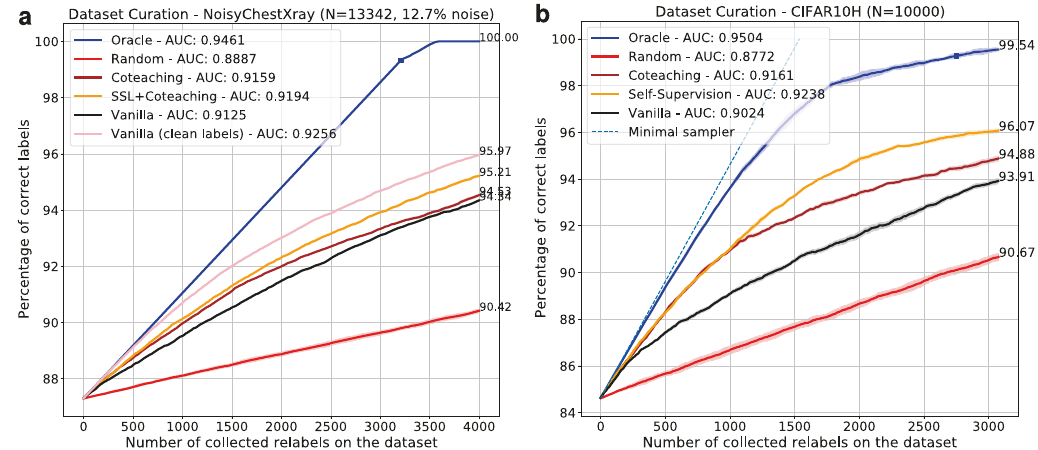
Fig. 3 Results of the label cleaning simulation on training datasets. a NoisyCXR ( η = 12.7%); b CIFAR10H ( η = 15%). For a given number of collected labels ( x -axis), a cost-ef fi cient algorithm should maximise the number of samples that are now correctly labelled ( y -axis). The correctness of acquired labels is measured in terms of accuracy. The area-under-the-curve (AUC) is reported as a summary of cleaning ef fi ciency of each selector across different relabelling budgets. The upper and lower bounds are set by oracle (blue) and random sampling (red) strategies. The pink curve ( a ) illustrates the practical “ model upper bound ” of cleaning performance when the selector model is trained solely on clean labels, its performance being bound to the capacity of the model to fi t the data. Shaded areas represent ± standard deviation over 5 random seeds for relabelling.